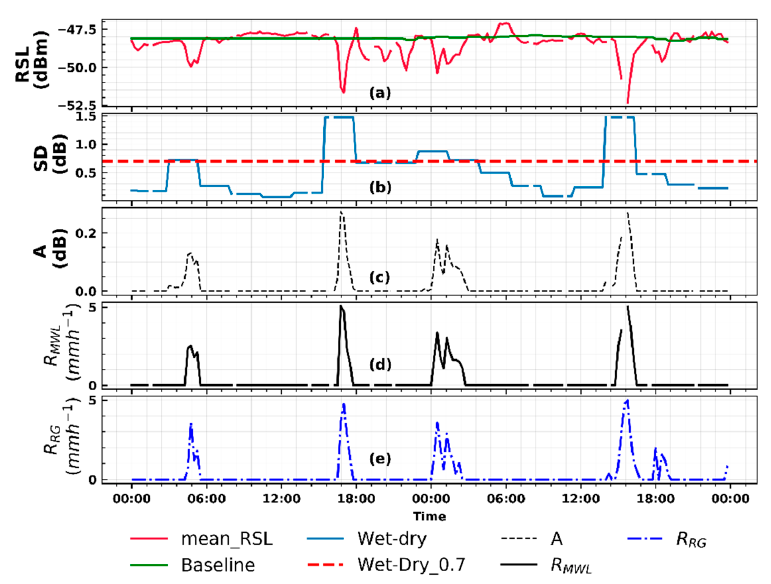
Figure 3. From raw RSL to rainfall using MWL data from Naivasha, on 4 June 2018 to 5 June 2018. ( a ) mean and reference RSL ( b ) rolling standard deviation with a threshold of 0.7 dB for detecting wet/dry periods ( c ) attenuation ( d ) CML derived rainfall intensities ( e ) rain gauge derived rainfall intensities.